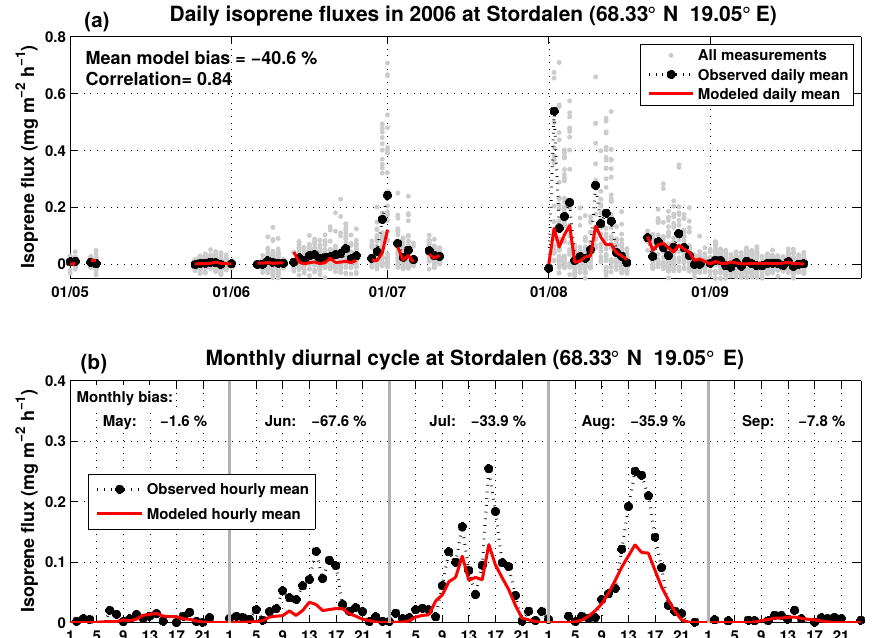
Figure 7. Modeled (red) and measured (black and gray) daily isoprene fluxes in Stordalen in 2006 (Holst et al., 2010). The model (H3 simulation) uses the local emission factor (SEF = 1.6mgm − 2 h − 1 ). The lower panel shows the monthly diurnal cycle for the modeled (red) and measured (black) isoprene